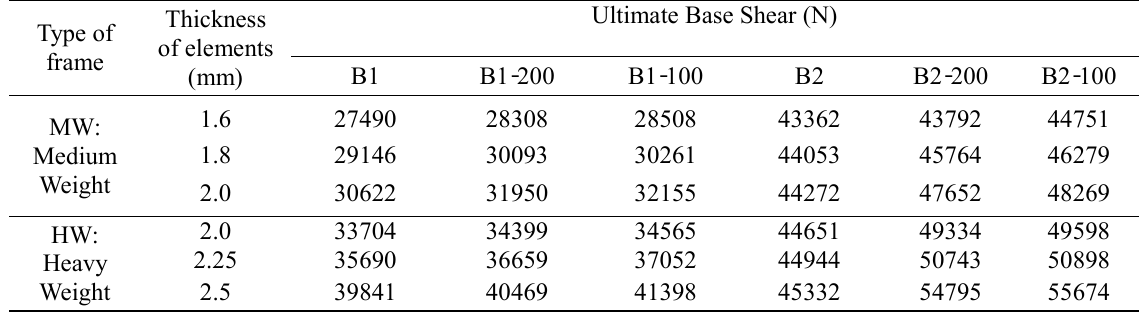
Variation of ultimate base shear of B1 and B2 type frames with respect to section thickness and use of spacer bars (as per UBC-1997 and FEMA-356 Inverted Triangular Loading).